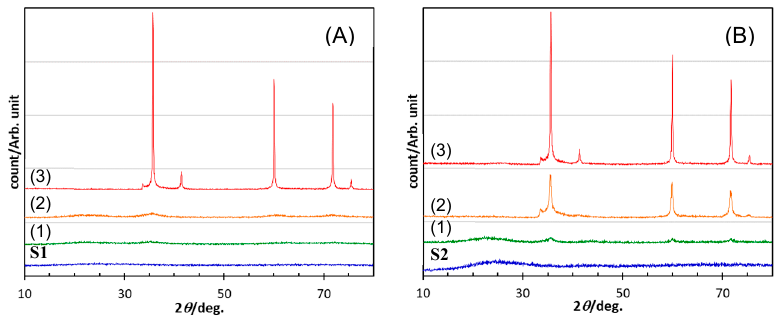
Figure 7. XRD patterns of S1 and S2 synthesized by pyrolysis at 800 °C, and those after heat treatment at ( 1 ) 1400, ( 2 ) 1600 and ( 3 ) 1800 ◦ C. Polymeric precursors: ( A ) VH-SQ and ( B ) St-H-SQ.